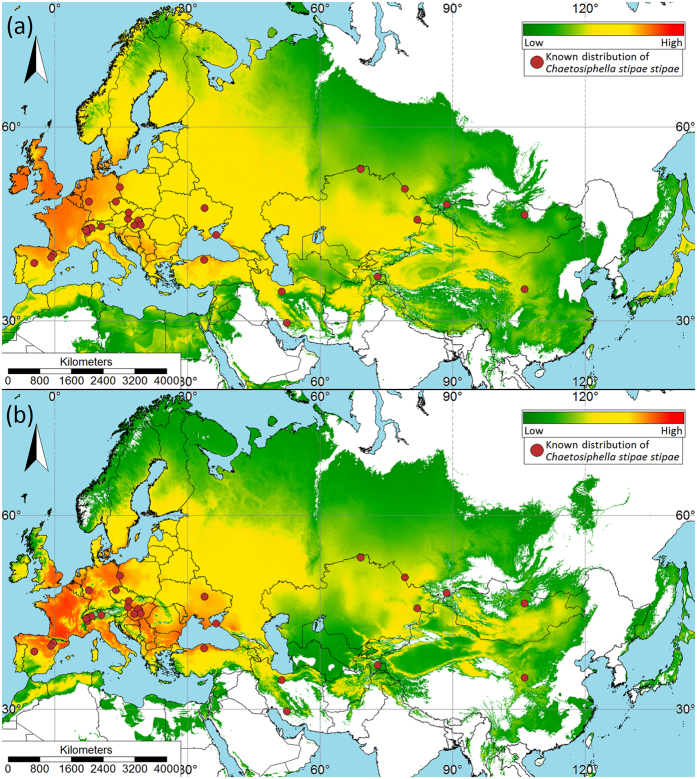
Maps of potentially suitable niches for Chaetosiphella stipae stipae.(a) Model based only on climate variables, and (b) model based on climate variables and outcome model of potential distribution of Stipa species. Circles represent known locations of aphids. Scale bars show Maxent logistic output (used for visualization purposes); higher values (warmer colours) indicate higher predicted suitability. The map was plotted using SAGA GIS 3.0.060 (http://www.saga-gis.org); projection – World Mercator (EPSG: 3395).